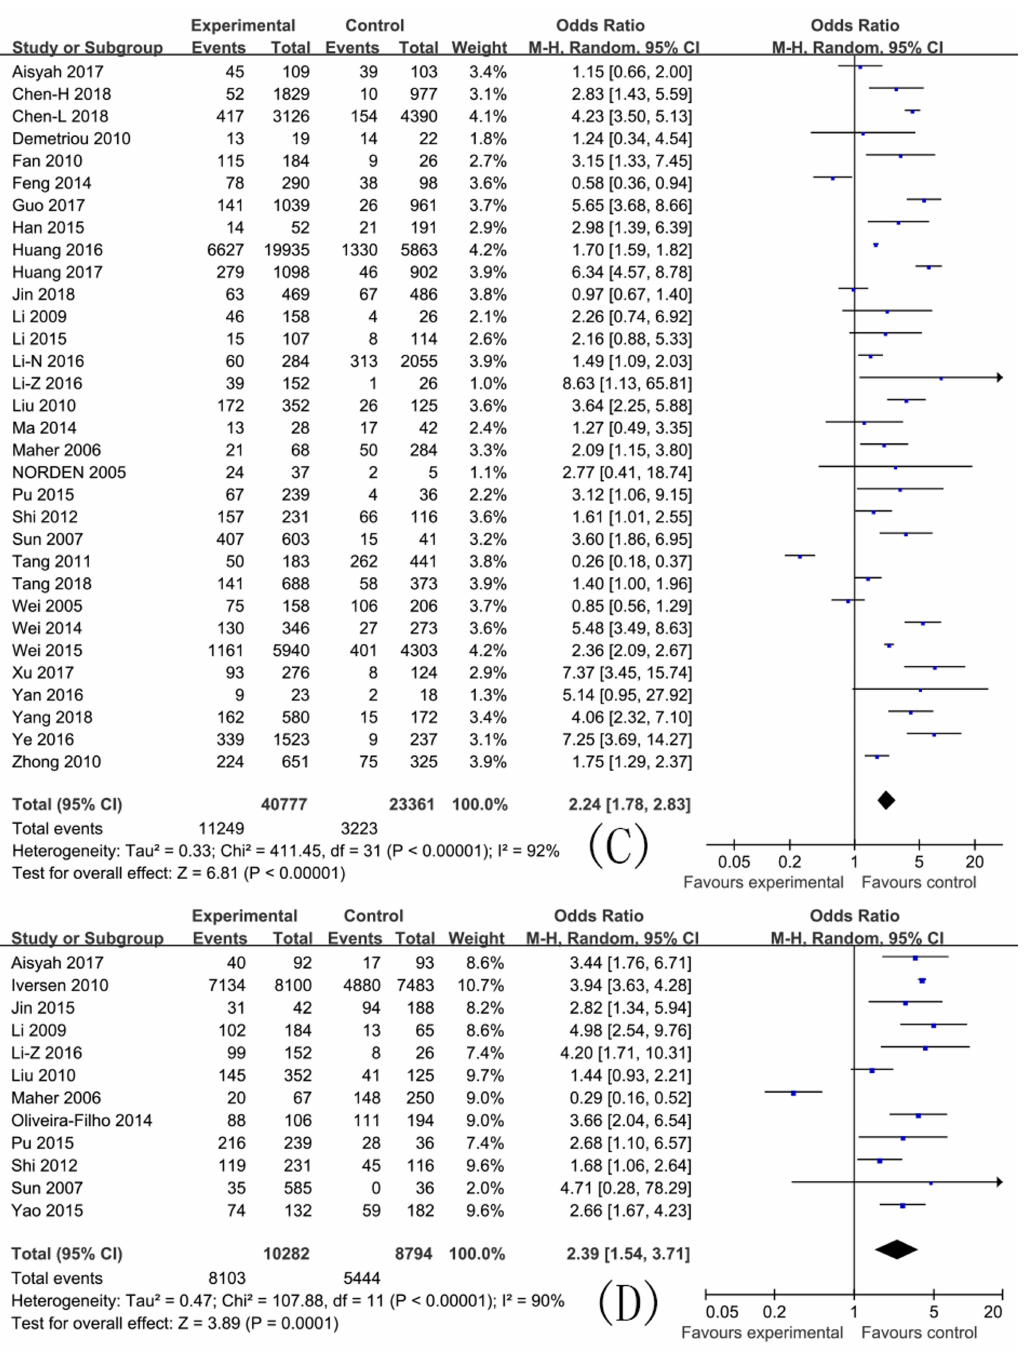
Figure 3. E ff ects of pooled ORs for factors correlating to the development of HCV infection among drug users (( C ) Sharing needles and syringes; and ( D ) Duration of drug use > 5